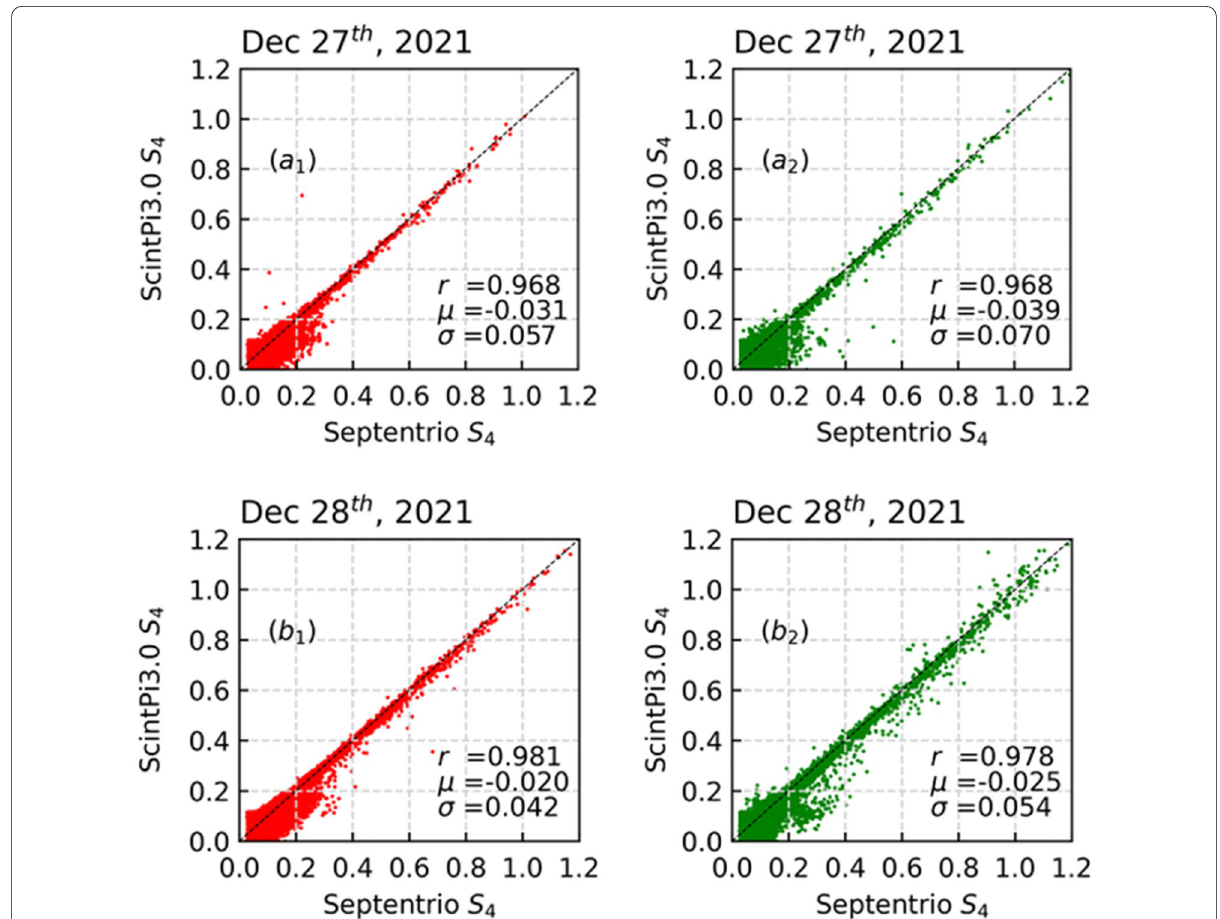
Fig. 6 Comparisons between S 4 values measured on December 27 and 28, 2021 by the ScintPi 3.0 and Septentrio PolaRx5S. These monitors were collocated in Presidente Prudente, Brazil. Comparisons for L1 (~ 1.6 GHz) signals are shown in panels ( a1 ) and ( b1 ), while comparisons for L2 signals (~ 1.2 GHz) are shown in panels ( a2 ) and ( b2 ). Each panel shows the coefficient of linear correlation ( r ), the average value ( µ = � S 4, Sci − S 4, Sep � ) and standard deviation ( σ ) of ScintPi 3.0